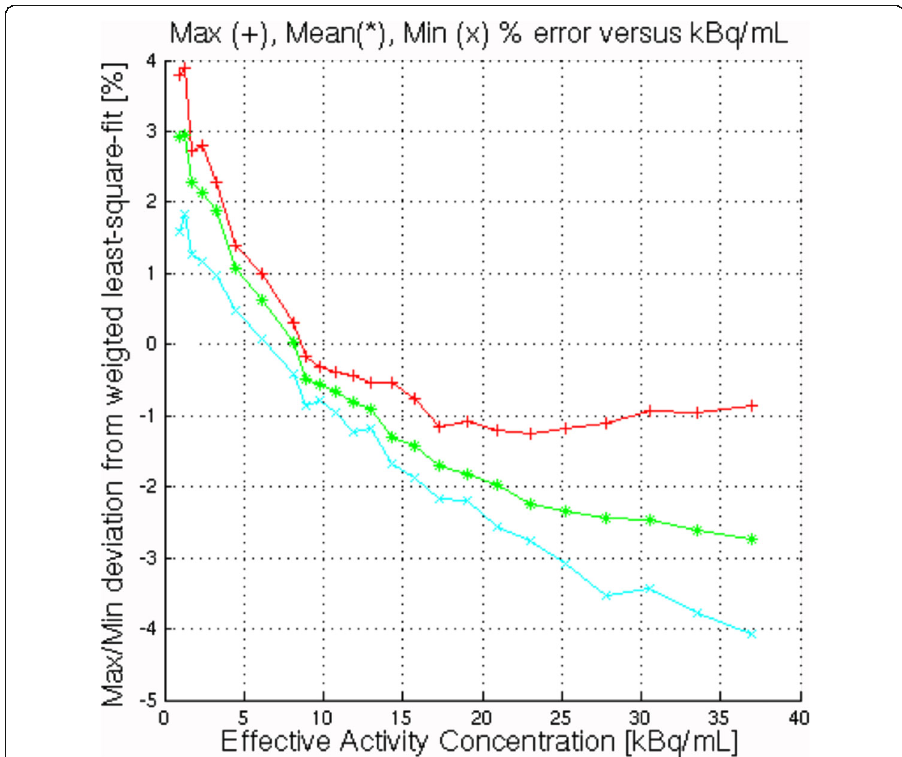
Fig. 4 Quantitation accuracy as a function of effective activity concentration. These errors are determined versus least squares fit of quantitation values below peak NECR. Maximal, minimal and mean absolute errors are given over all image slices except the 6 end slices on both ends of the